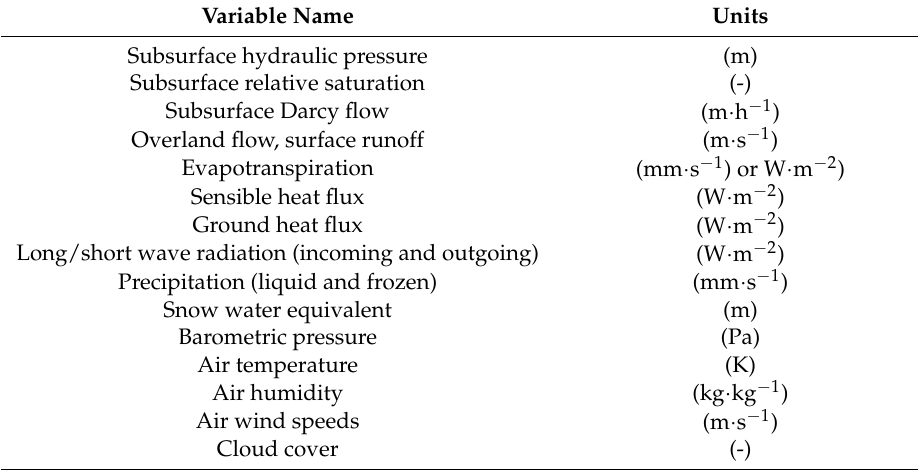
Table 1. Selected essential states and fluxes simulated by the terrestrial monitoring